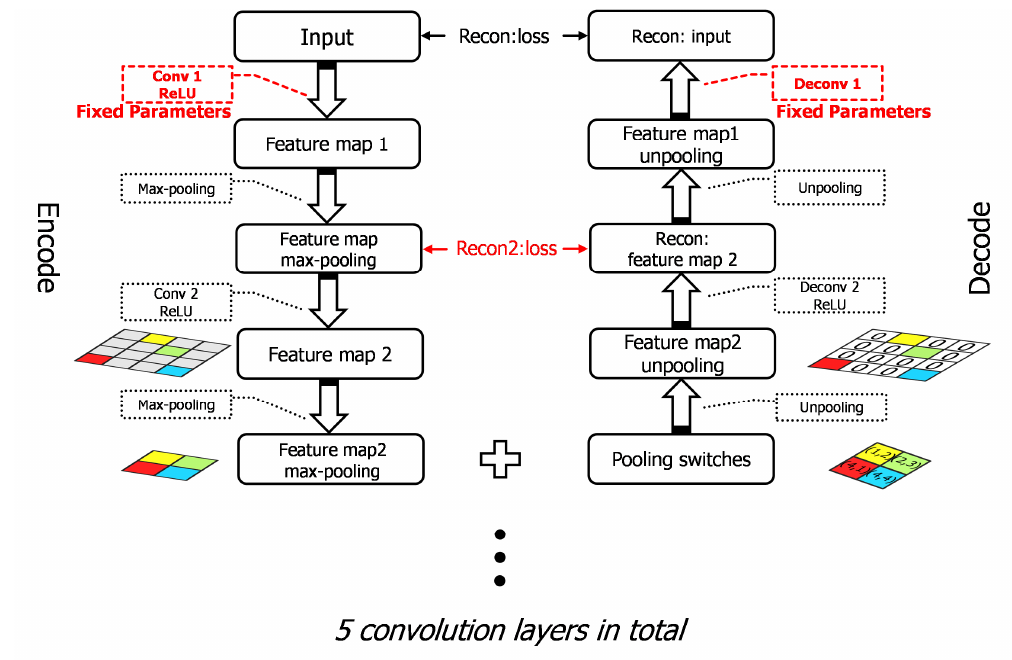
Figure 3. Stacked convolutional auto-encoders in layer-wise fashion for the second